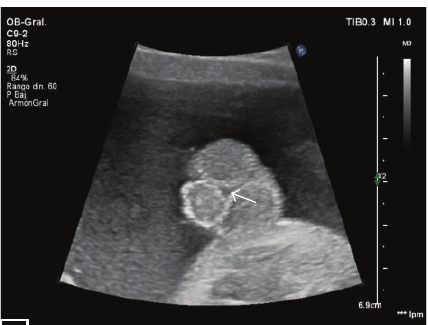
Figure 1: Two-dimensional image where we can see a small penis ventrally oriented and located between the scrotal folds, which include both testes. In this projection it is possible to see the anomalous localization of the meatus (arrow).